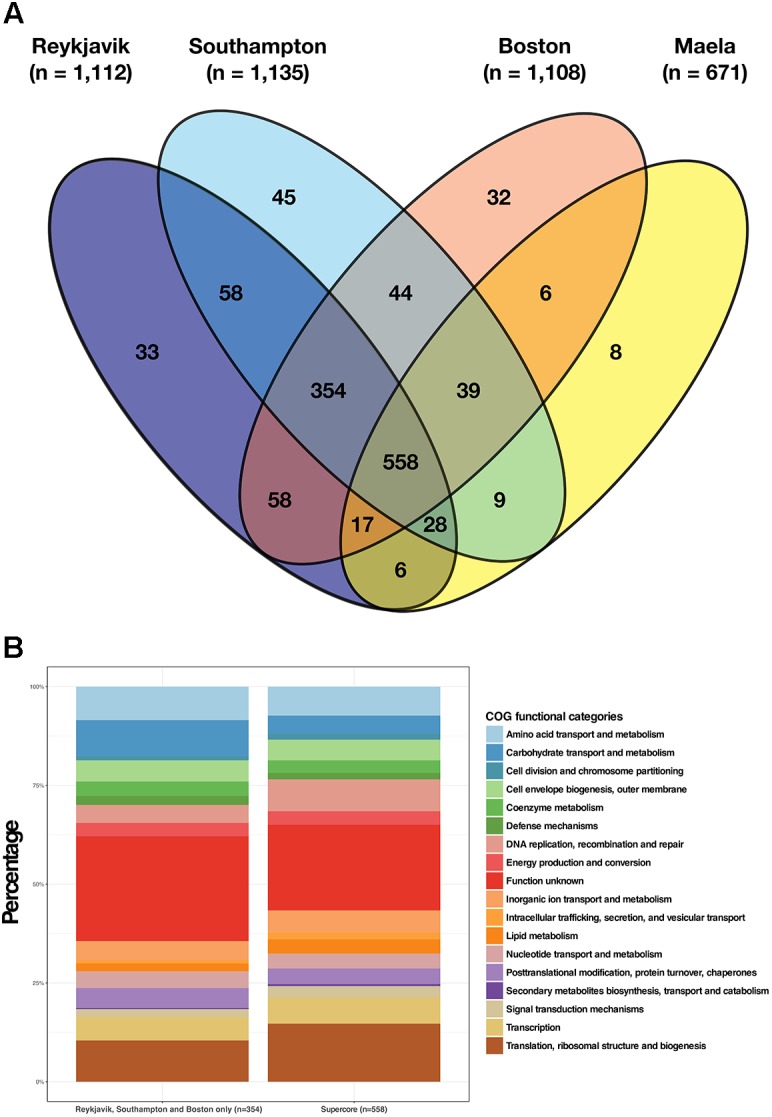
Illustration of the estimated core genes in each dataset and the shared supercore genome. (A) Venn diagram depicting the numbers of core genes shared by the four datasets and the 558 genes in the shared supercore genome; (B) COGs functional categories for the supercore genes as compared to the additional core genes shared by the Reykjavik, Southampton and Boston datasets only.